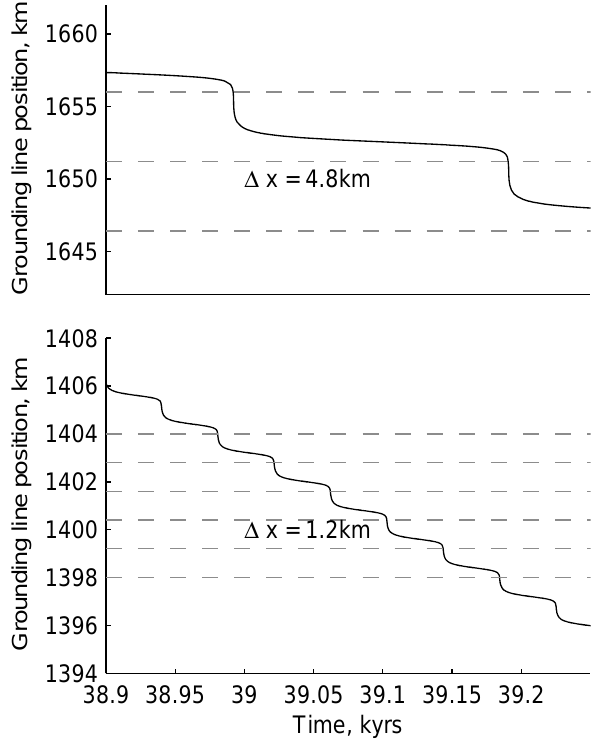
Fig. 4. Close up of the LI B1 retreat simulations shown in Fig- ure 2. The horizontal dashed lines indicate grid point locations at 1x = 4.8km resolution between 1645km and 1660km (upper plot) and at 1x = 1.2km resolution between 1398km and 1404km (lower